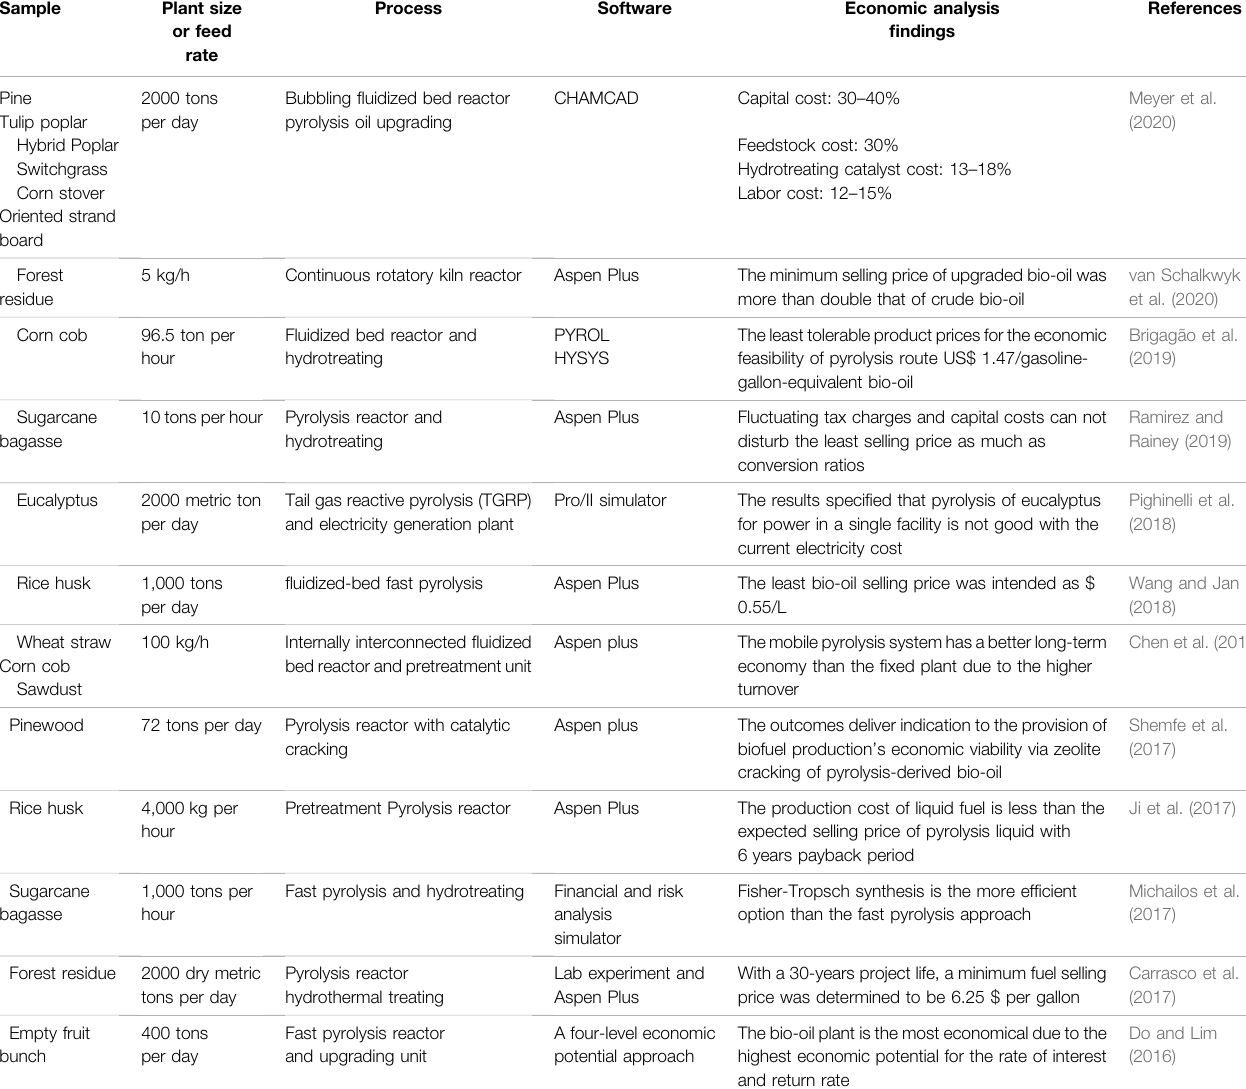
TABLE 2 | Techno-economical analysis of bio-oil produced from fast